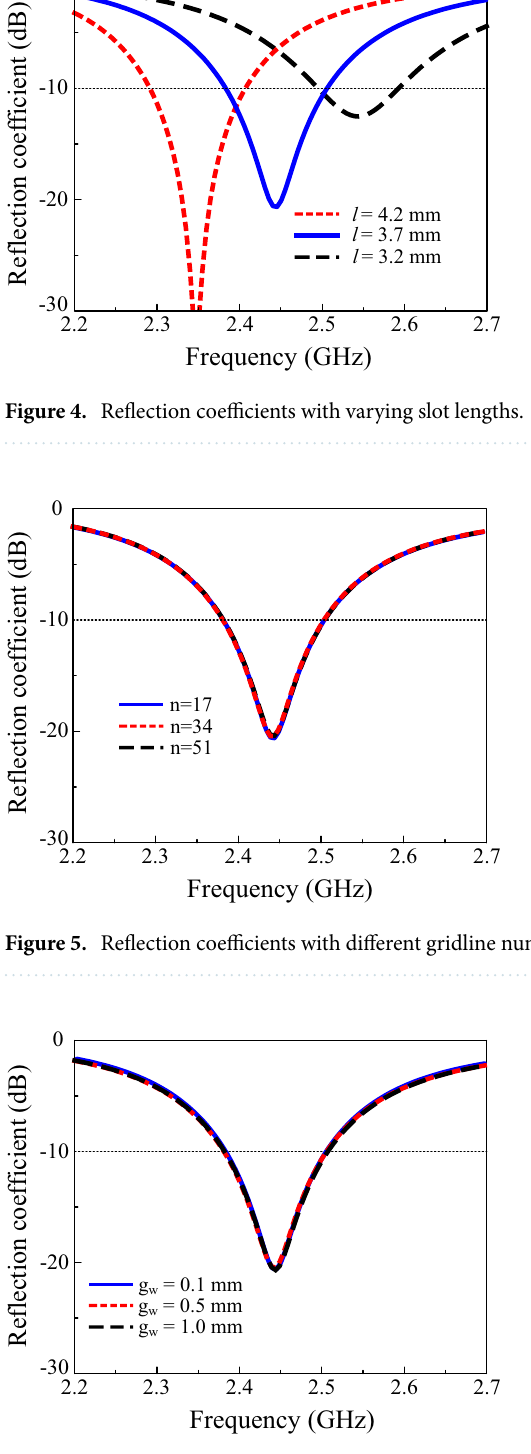
Figure 6. Reflection coefficients with different gridline